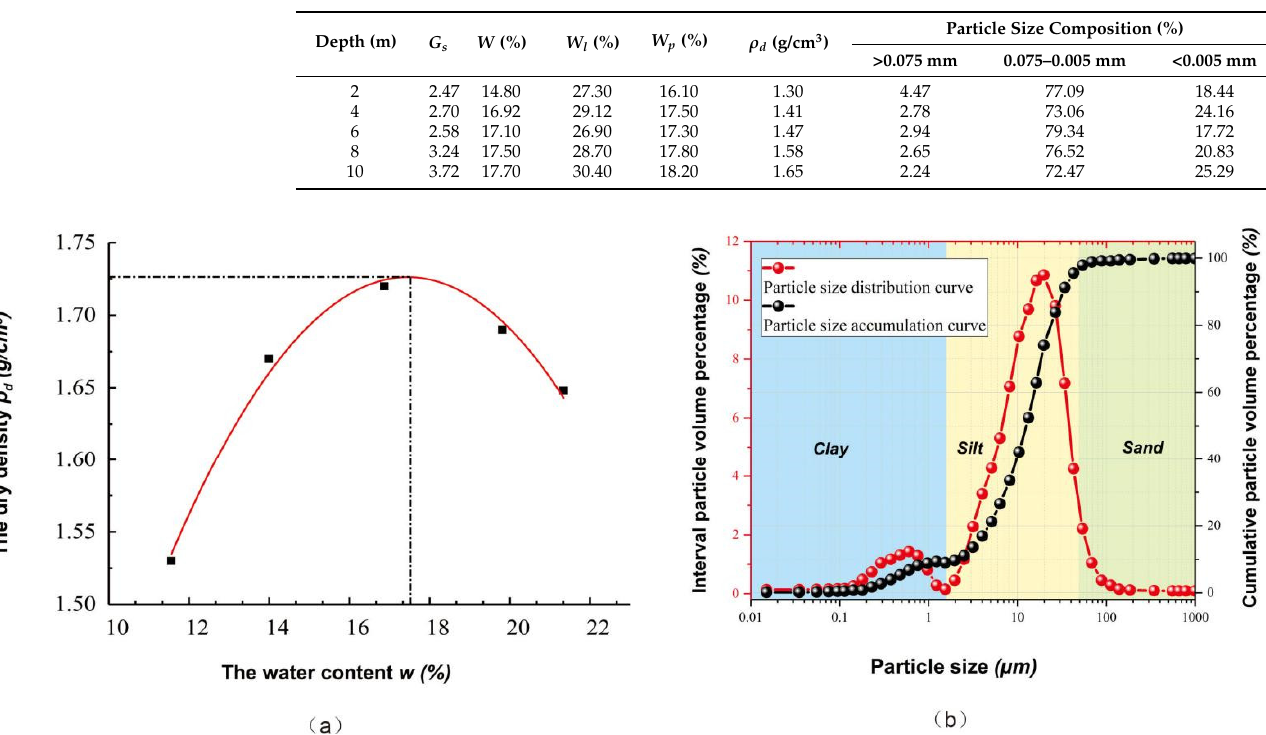
Figure 1. ( a ) The loess distribution map of China and ( b ) the geological map of the loess plateau. ( c ) Sample preparation process and pictures of the test instrument. Table 1. The physical properties of the experimental soils.